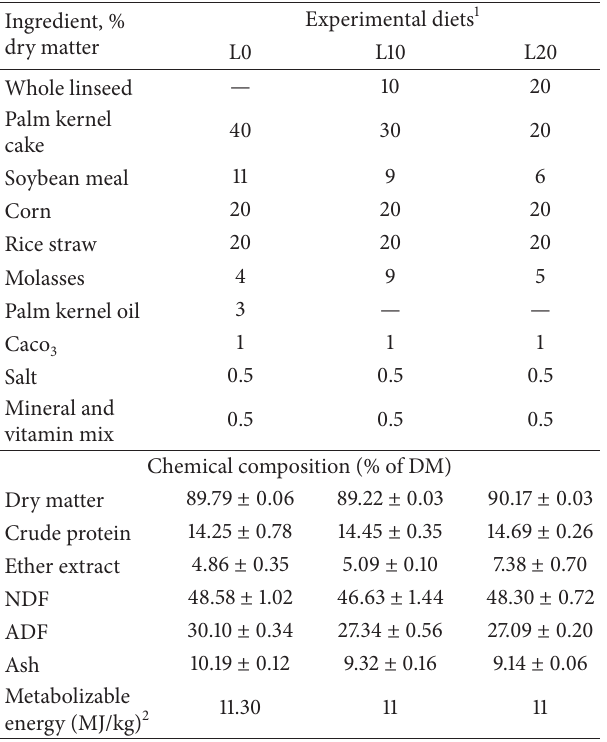
Table 1: Formulation and proximate analyses of the experimental